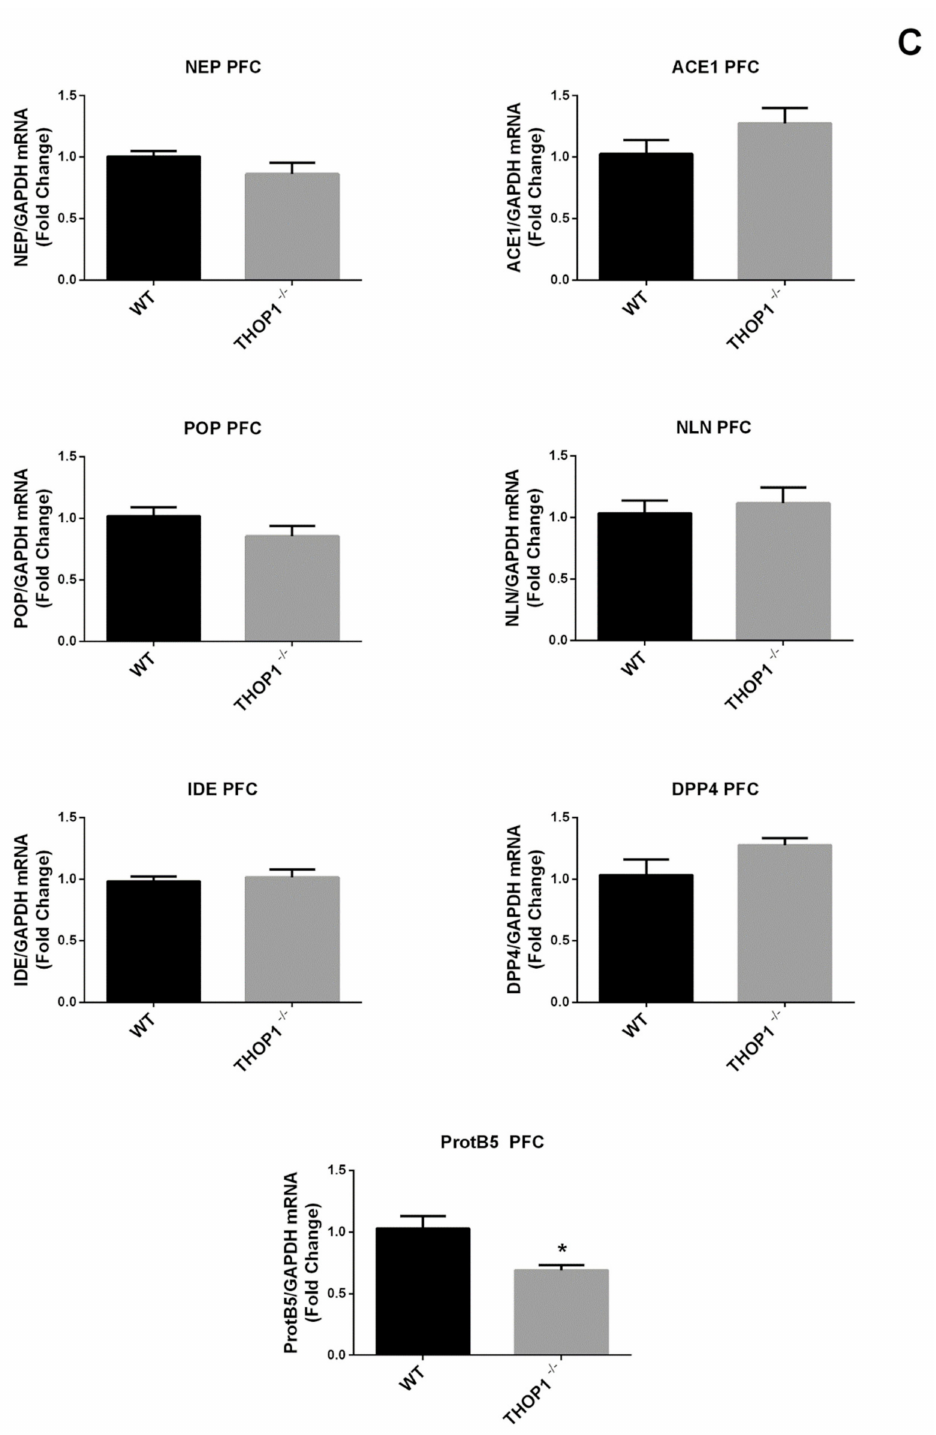
Figure 2. Gene expression of peptidases and proteasome beta5 subunit in di ff erent areas of mouse brain. qRT-PCR was used to investigate the mRNA levels for specific peptidases or proteasome beta5-subunit (ProtB5): ( A ) striatum (ST), ( B ) hippocampus (HC), and ( C ) prefrontal cortex (PFC). Neprilysin (NEP), angiotensin converting enzyme 1 (ACE1), prolyl-oligopeptidase (POP), insulin degrading enzyme (IDE), dipeptidyl peptidase 4 (DPP4), or neurolysin (NLN). Results are expressed as mean ± S.E.M. Statistical significance was determined by Student’s t -test. * p < 0.05. n =